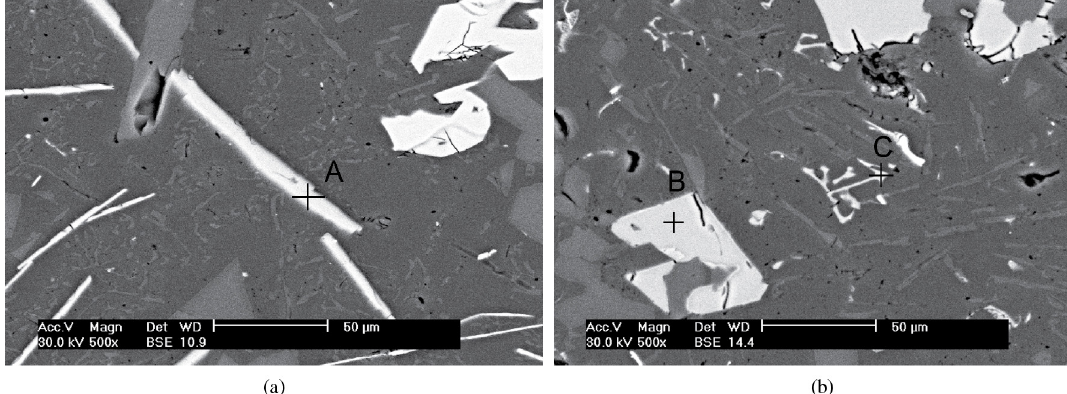
Figure 6. (a) Enlarged BSE micrograph of CS-cast A1 alloy; (b) Enlarged BSE micrograph of CS-cast A2 alloy.